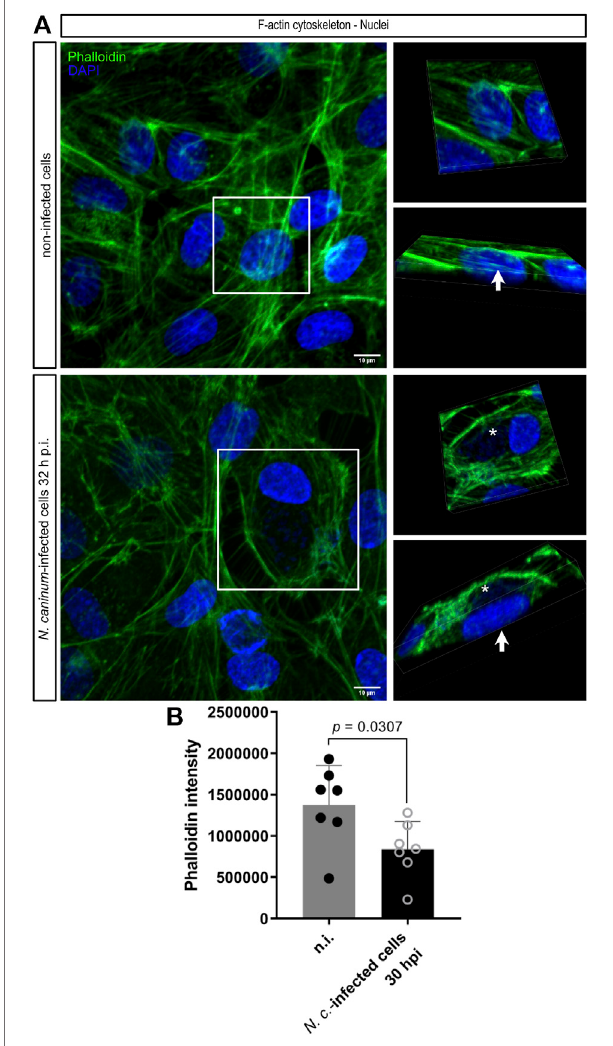
FIGURE7| F-actin-basedcytoskeletalnuclearstructuresin N.caninum - infectedBUVECs. (A) ThreebiologicalBUVECreplicateswereinfectedwith N. caninum tachyzoites and, after 32 h p. i., submitted to F-actin (green) and DAPI (blue) staining. Pictures of the whole cell were taken in order to visualize the actin network in both cell conditions. In the right panel, the 3D volume image reconstruction of only one host cell is shown to display in detail the actin fi lament localization inside the cell. The white arrows show the nuclear region covered by the actin cytoskeleton, and the asterisks point out the parasite localization. (B) FACS-based quanti fi cation of the F- actin in both non-infectedand N.caninum- infected hostcells. Scalebar represents 10 µm. Bars represent the median ±SD of six biological